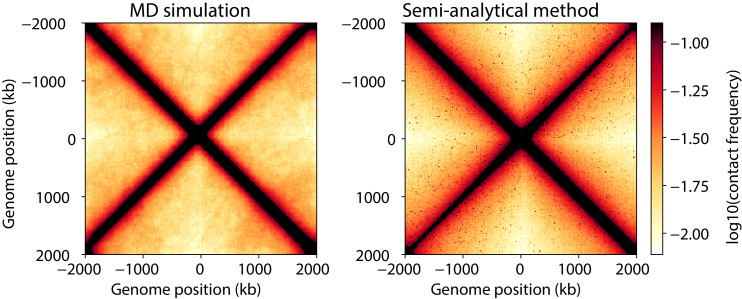
Contact maps generated from molecular dynamics simulations as compared to the semi-analytical method.